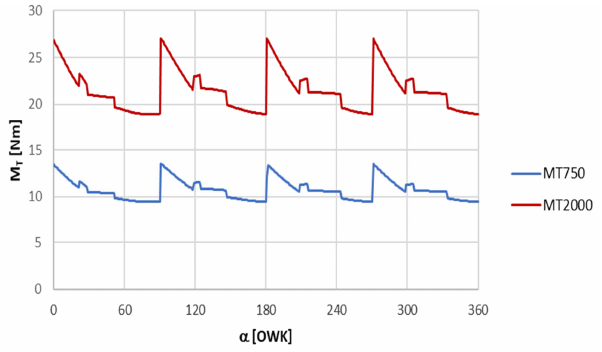
Fig. 18. The technically dry friction torque in camshaft bearings as a function of its rotational angle, for two values of camshaft rotational speed equal to 750 rpm and 2000 rpm